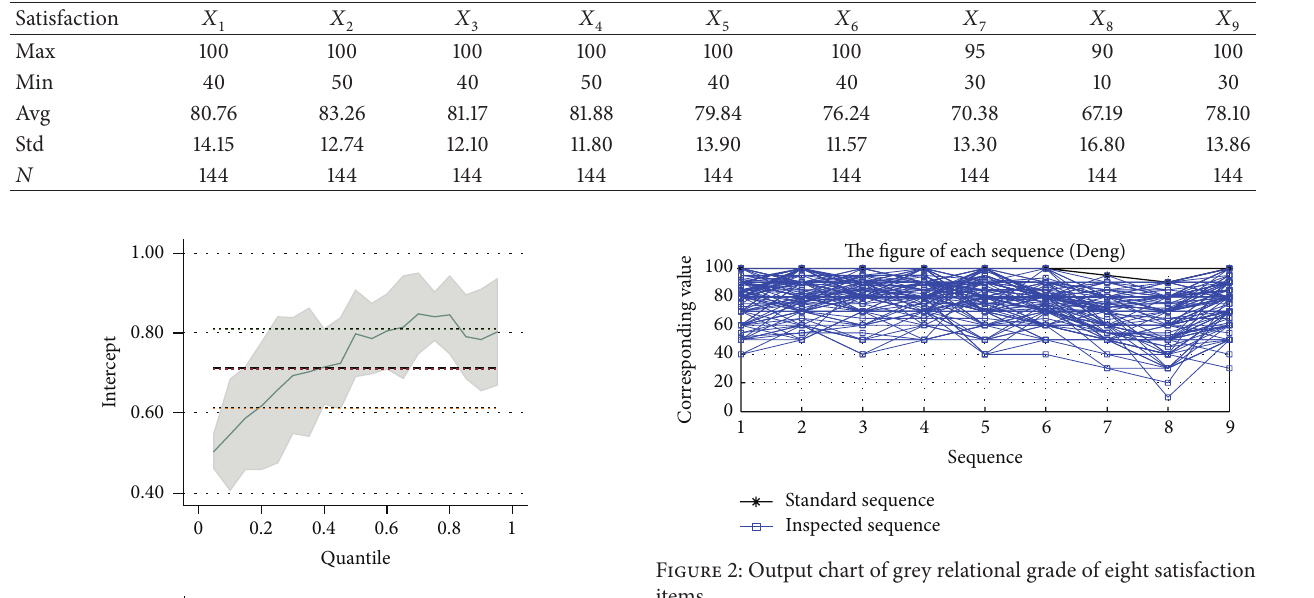
Table 1: Descriptive statistic value of the nine satisfaction variables.